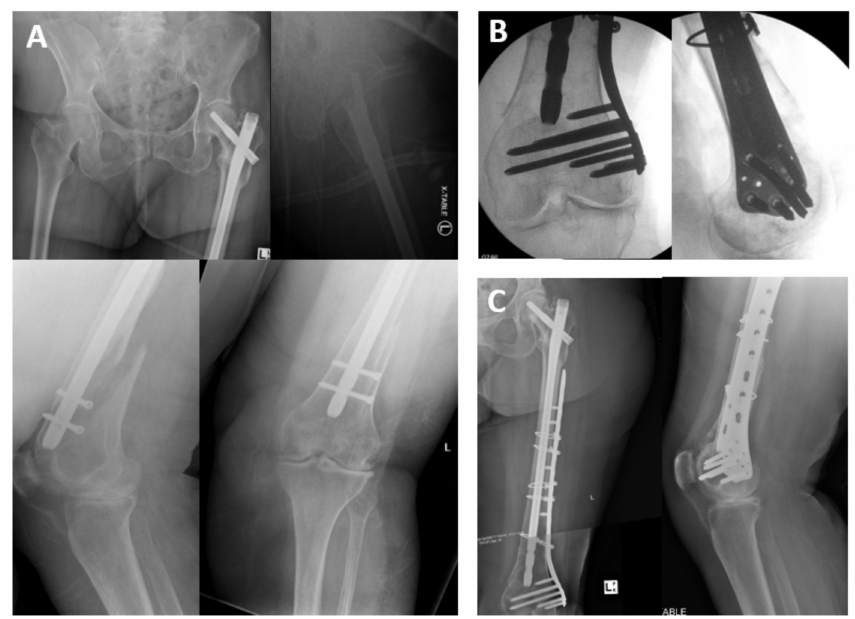
Figure 1. 998 days post-treatment for A3.3 fracture, a peri-implant fracture around the distal nail is sustained ( A ). This is managed by removal of the distal screws and plate osteosynthesis ( B ) followed by uneventful fracture union ( C ).